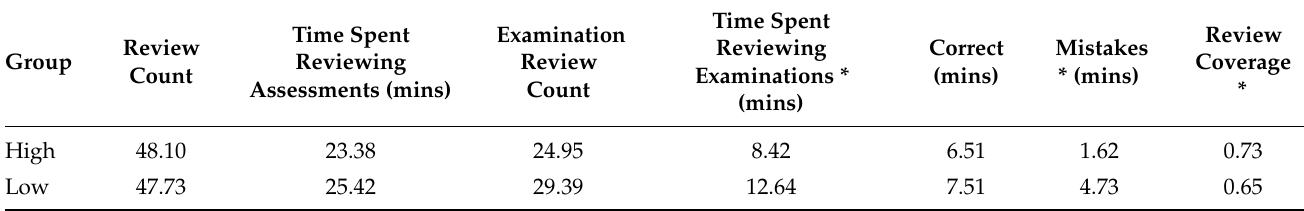
Table 3. Comparison of the system use and reviewing behaviors between the high-achieving and low-achieving students.